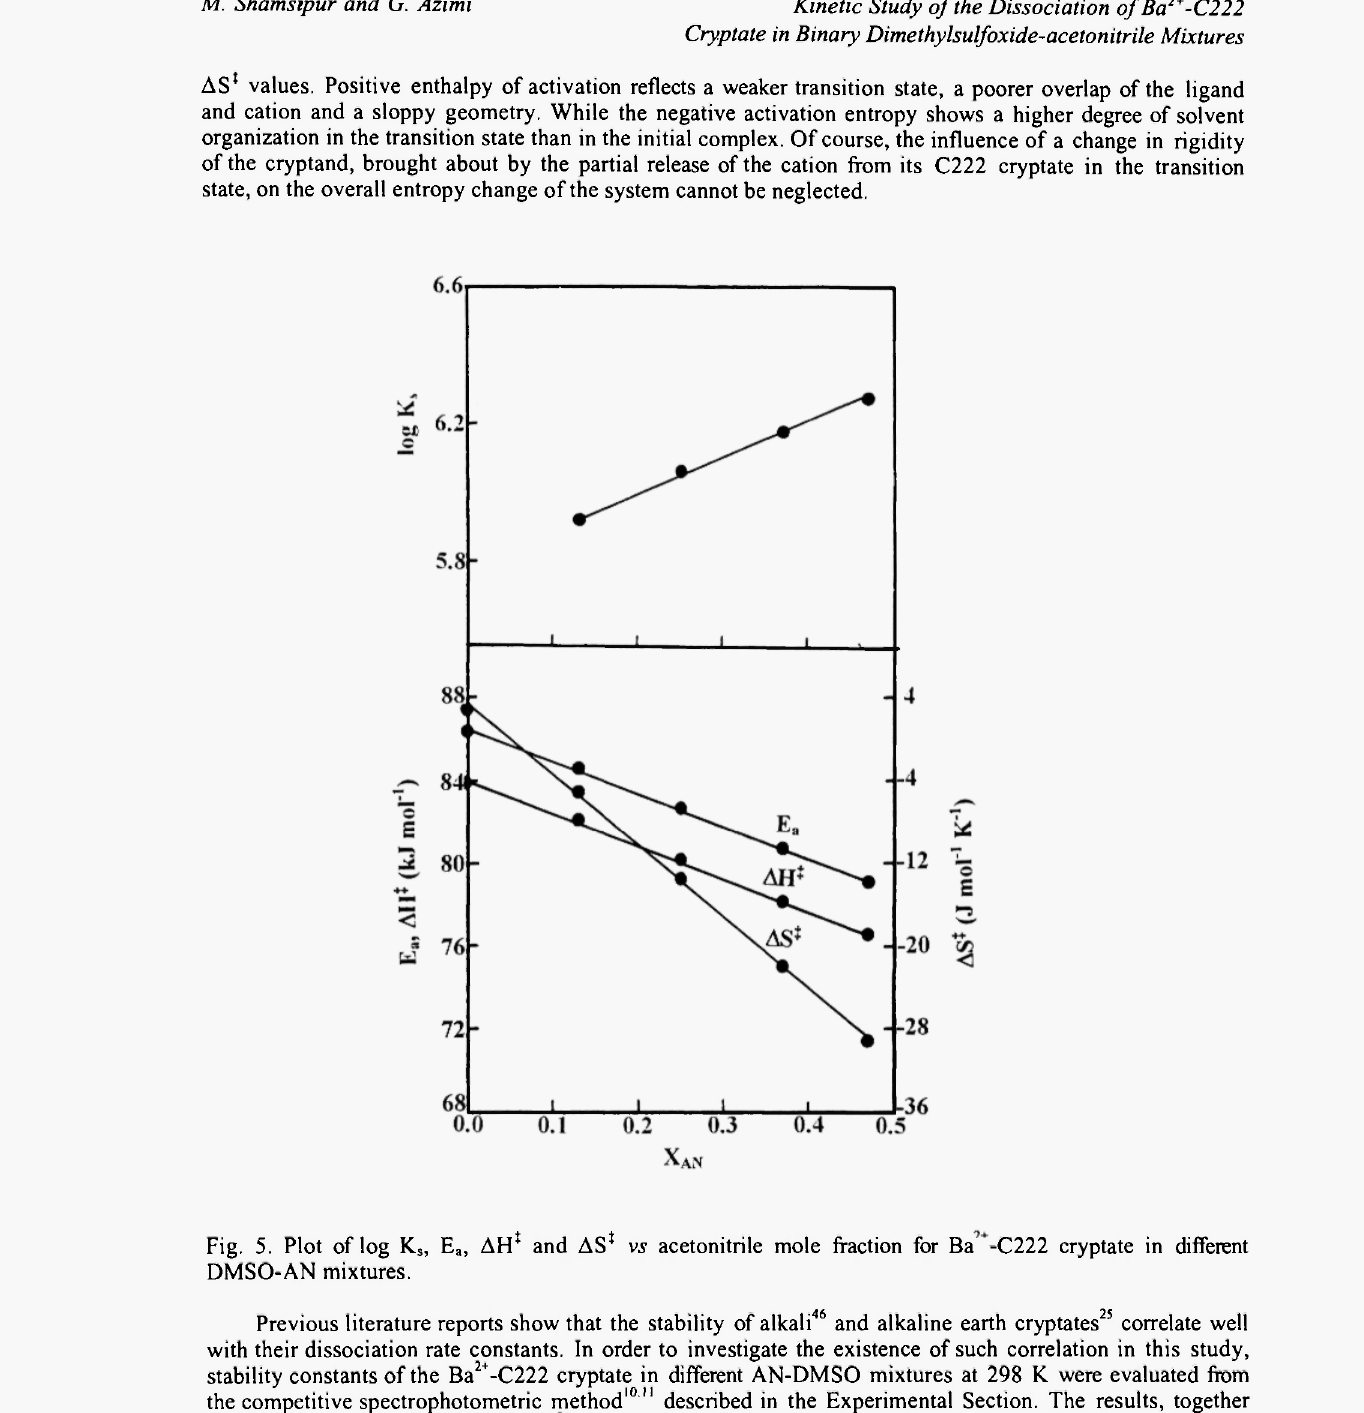
Fig. 5. Plot of log K s , E„ AH J and AS 1 vs acetonitrile mole fraction for Ba -C222 cryptate in different DMSO-AN